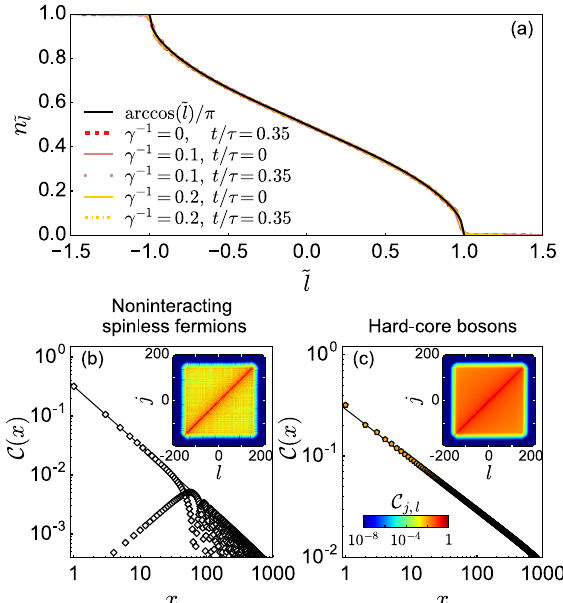
FIG. 2. Site occupations and nonlocal correlations in current- carrying states. (a) Site occupations n l ð t Þ ¼ h ψ ð t Þj ˆ n l j ψ ð t Þi versus ~ l ¼ l γ ð t Þ = ð 2 L Þ . Results are shown for N ¼ 200 particles, differ- ent values of γ , and different times. The black solid line is the scaling solution n ~ l ð t Þ ¼ arccos ð panels in (b) and (c) display C ð x Þ ≡ C 0 ;x , where C j;l ¼ jh noninteracting spinless fermions (b) and C j;l ¼ jh core bosons (c), as a function of x for N ¼ 2000 particles, γ − 1 ¼ 0 , at time t= τ ¼ 0 . 35 . The solid lines overlapping with the numerical results are C ð x Þ ¼ 1 = ð π x Þ in (b) and C ð x Þ ¼ 0 . 29 = in (c) [33]. The insets in (b) and (c) display the absolute values of all elements of the one-body density matrix for the same model parameters and time as the main panels, but calculated for N ¼ 200